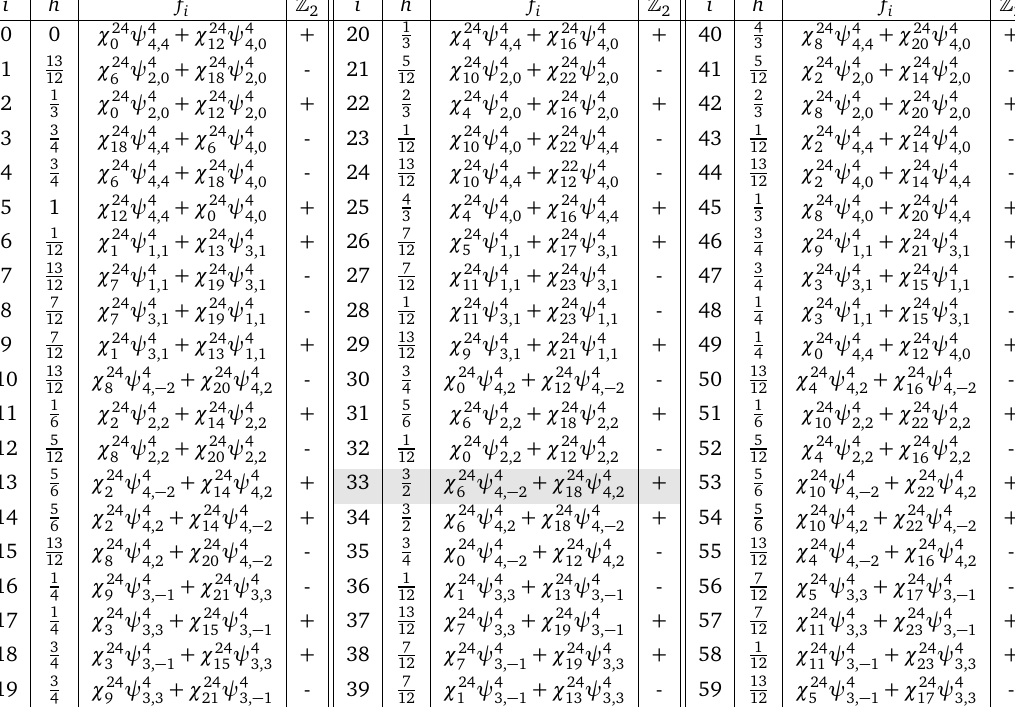
of 60 primaries i theory and the (cid:90) 24